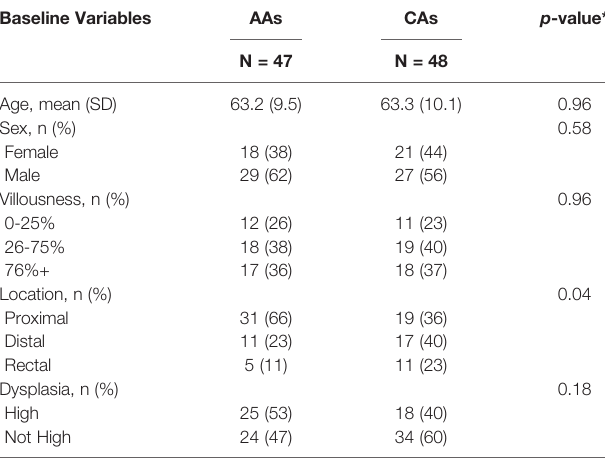
TABLE 1 | Patient and lesion characteristics at diagnosis in African Americans (AAs) and Caucasian Americans (CAs). Baseline